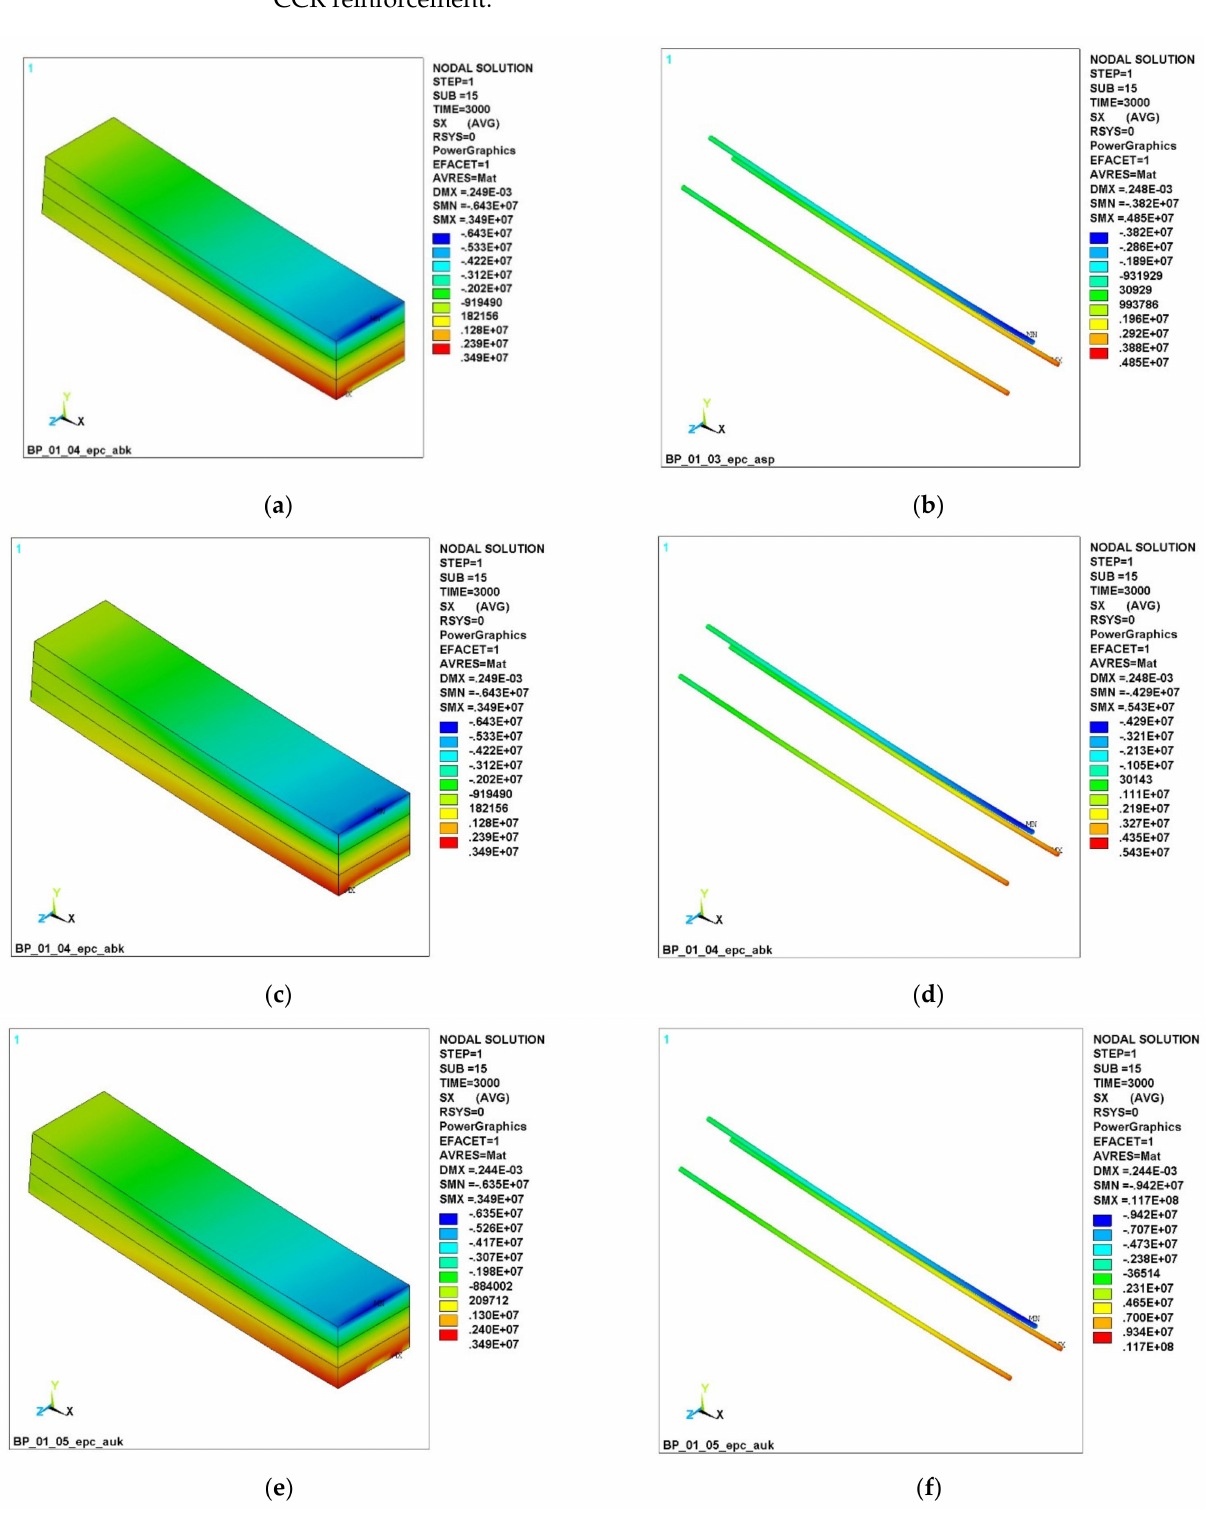
Figure 5. Normal stress fields σ X at a load of 3000 N: ( a ) in concrete with GCR; ( b ) in GCR; ( c ) in concrete with BCR; ( d ) in BCR; ( e ) in concrete with CCR; ( f ) in